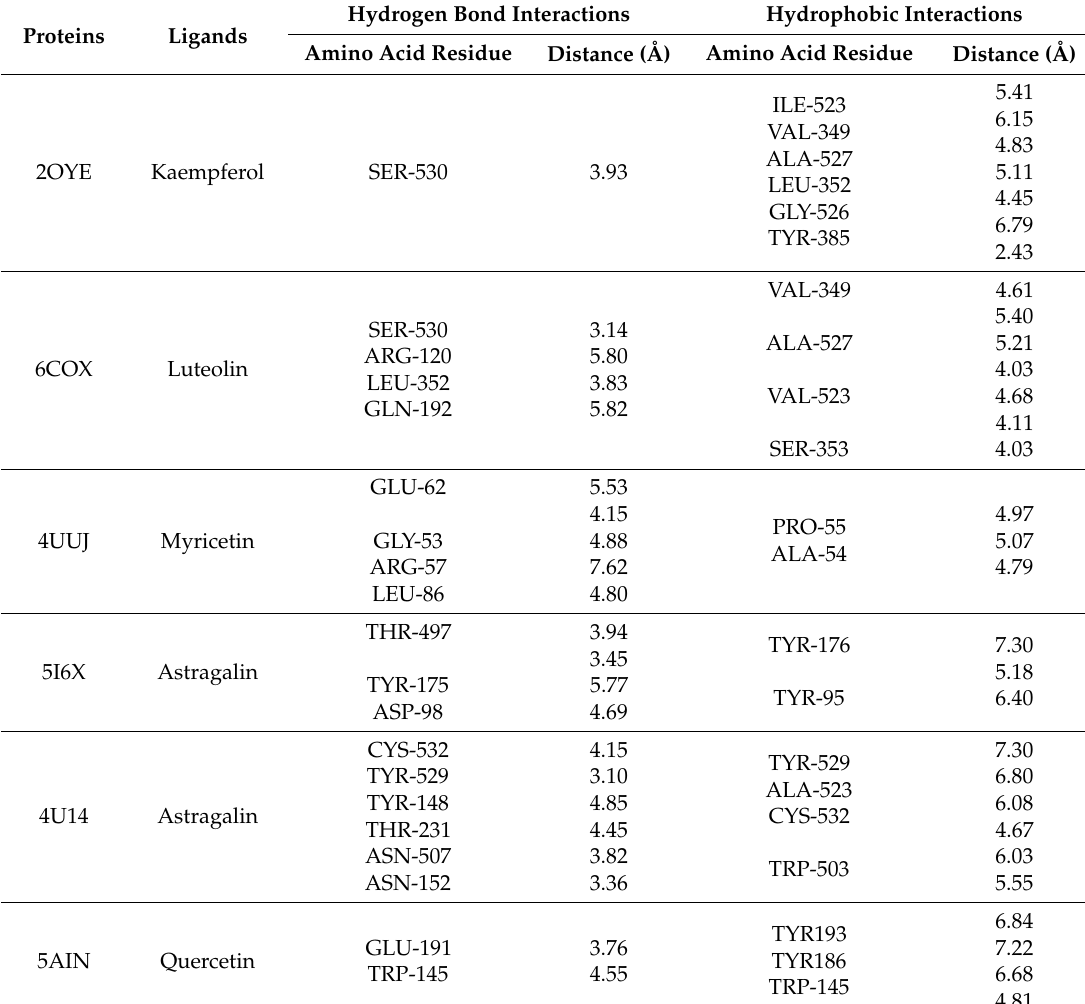
Table 4. Binding interactions of the major five compounds identified in the molecular docking study. Proteins